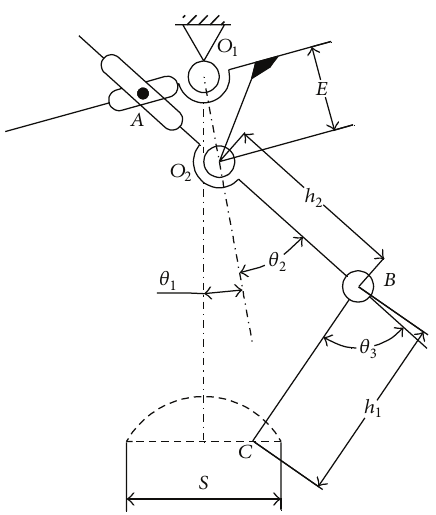
Figure 5: Schematic diagram of the walking mechanism.